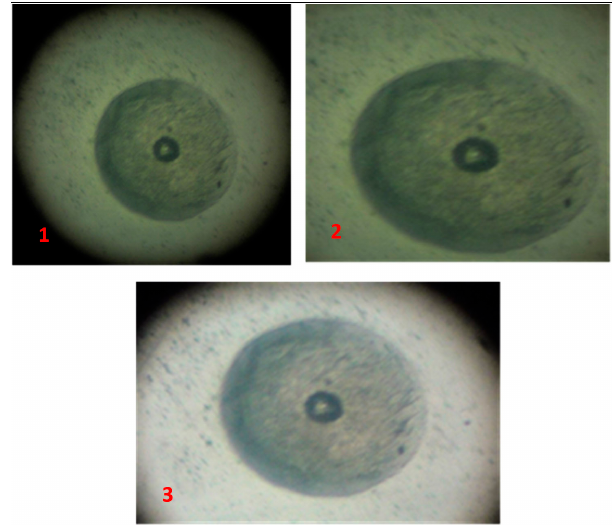
Fig. 1-3. Mycoplasmas colonies under dissecting and 10x light Table 1. Primers used to detect genus and Species of Mycoplasma gallisepticum strain Primer Sequence (5’-3’) Product Detection